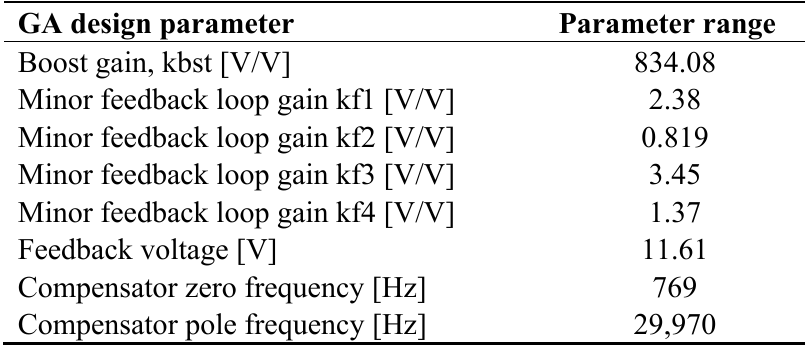
Table 6. Design Parameters for the Genetic Algorithm.